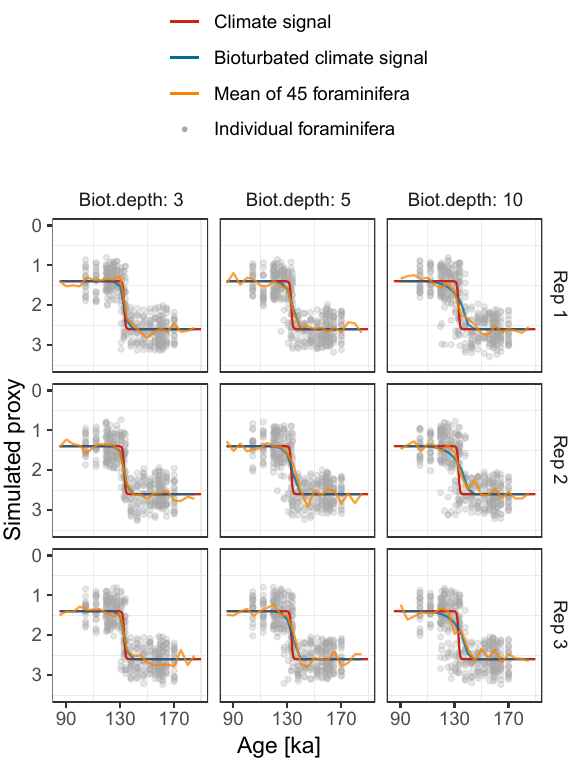
Figure 9. Simulated δ 18 O measured from single foraminiferal tests (circles) and bulk samples (lines). Subplots show six replications with the same